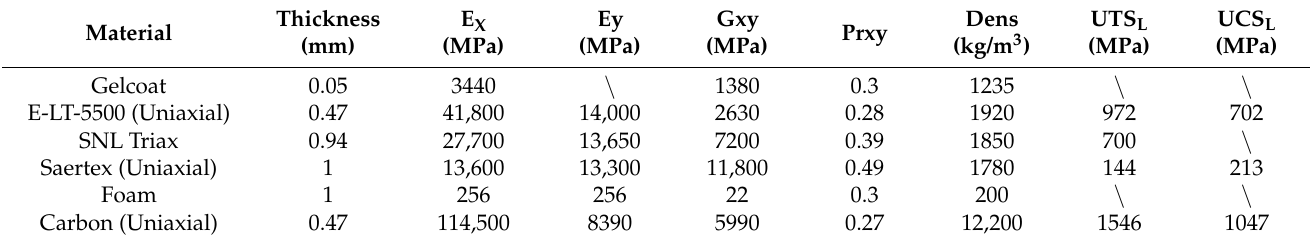
Table 1. Material properties of the composite